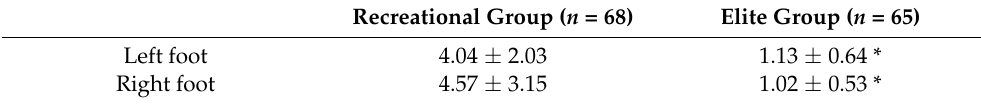
Table 6. Assessment of static rearfoot postural alignment in elite badminton